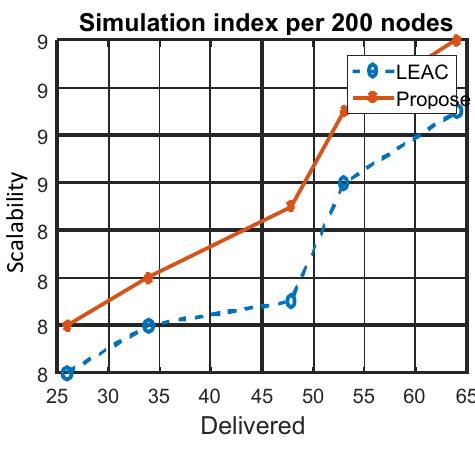
Figure 10. Data Packets Delivered for 200 Nodes